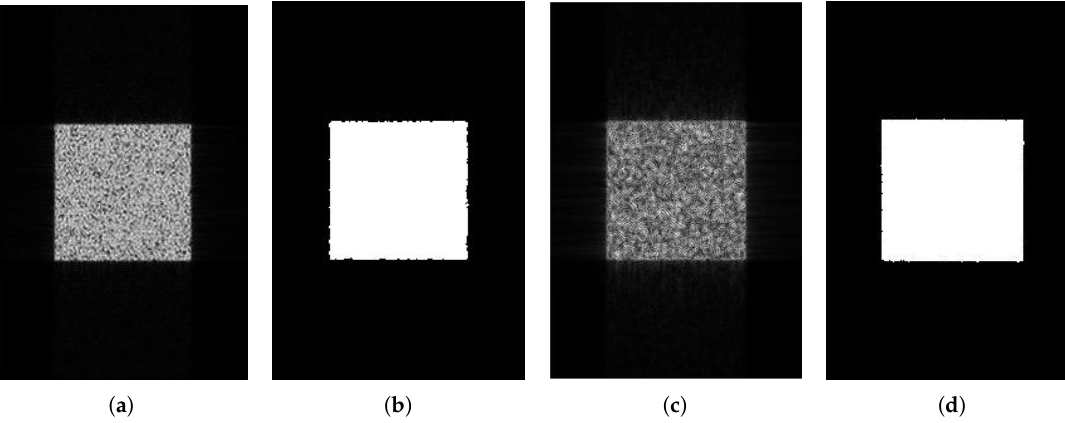
Figure 11. The imaging and image segmentation result of the rectangular area. ( a ) Original image; ( b ) image segmentation result of the original image; ( c ) edge-enhanced SAR image; ( d ) image segmentation result of the edge-enhanced SAR